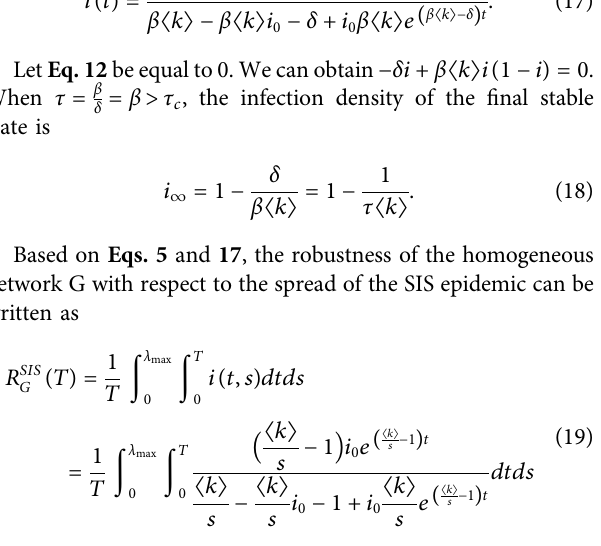
Figure 4 show that, when T < 15, R SIS BA > R SIS WS , i.e., the